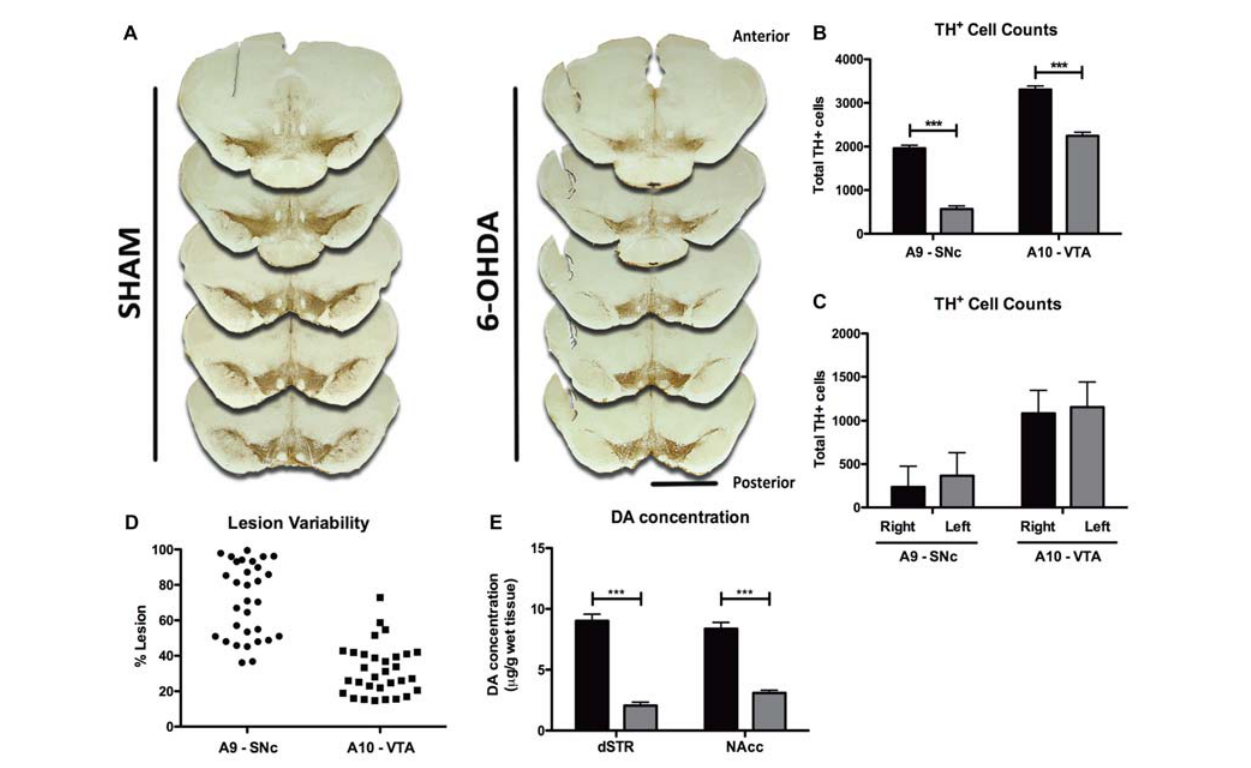
FIGURE 2 | Histological and neurochemical characterization of lesion extent. (A) Representative photomicrographs of the five tyrosine hydroxylase (TH)-labeled slices selected along the anterior-posterior axis for histological characterization of lesion extent. Scale bar = 2 mm. (B) Quantification of the total number of TH + cells counted bilaterally in A9 and A10 on the five selected slices of both sham (black bars, n = 10) and 6-OHDA animals (gray bars, n = 31). (C) Quantification of the number of TH + cells in each hemisphere of both A9 and A10 in 6-OHDA animals ( n = 31). (D) Representation of 6-OHDA lesion variability in A9 and A10 regions ( n = 31). (E) Measurement of DA content in the dorsal straitum (dSTR, sham: black bars, n = 31; 6-OHDA: gray bars, n = 29) and nucleus accumbens (NAcc sham: black bars, n = 31; 6-OHDA: gray bars, n = 31). Data presented as mean ± SEM. ∗∗∗ p < 0.0001.